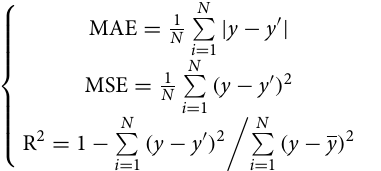
Fig. 6. For four physical attributes, all averaged L 1 and L 2 error is lower than 0.02 and 0.1. The low field criteria distributions indicate that our approach can reconstruct fields for different design variables with high fidelity.